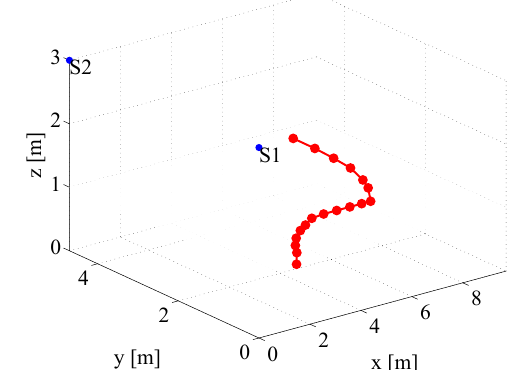
Figure 1. Two receivers are placed at 3m in height and presented by blue points. The path of the moving transmitter (18 positions) is presented by red points, joined by a red solid line.